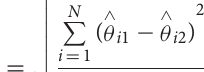
TABLE 3 | Fit statistics for the 21 trended anchor items in 1999, 2003, and 2007 TIMSS. TIMSS Unidimensional 3PL IRT model